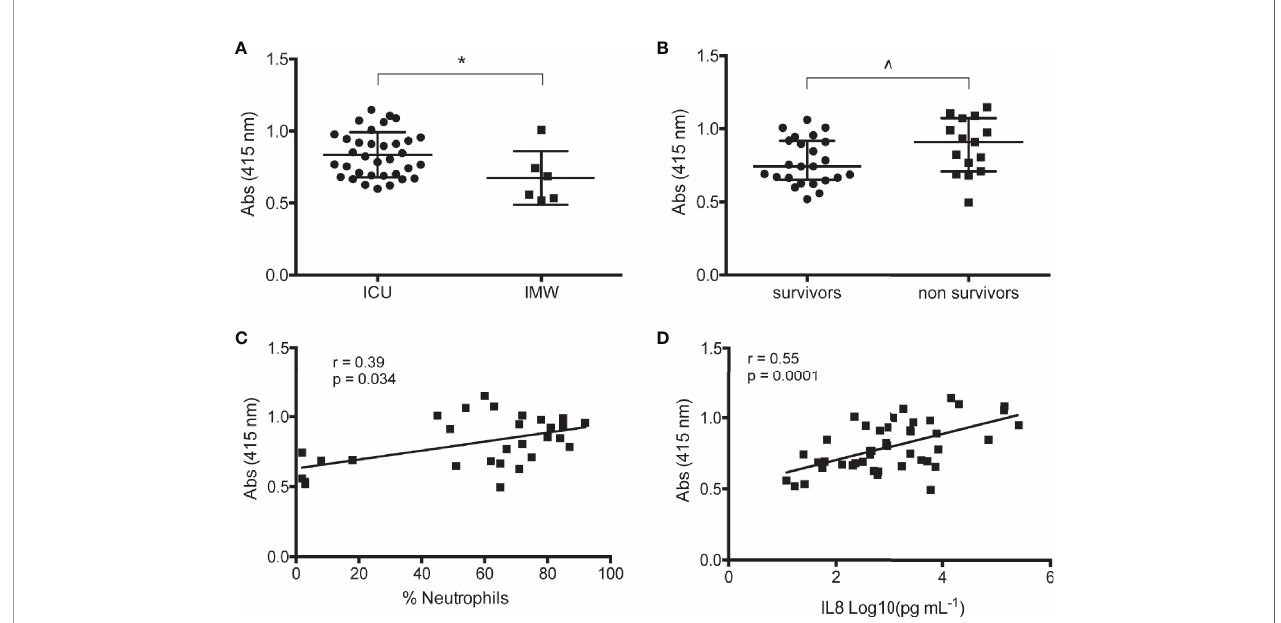
FIGURE 1 | Analysis of BAL COVID-19 patients. (A) Quanti fi cation of NETs in BAL of mild (IMW) and severe (ICU) patients. NETs were measured by free-DNA quanti fi cation reading absorbance at 415 nm. (B) Quanti fi ed NETs were compared dividing samples in survivors and non-survivors. (C) Correlation analysis between NETs and percentage of neutrophils counted in the respective BAL sample. (D) Correlation analysis between NETs and IL8 quanti fi ed in the respective BAL sample. Data are represented as median (IQR). *p < 0.05; ^p = 0.05. r = Spearman coef fi